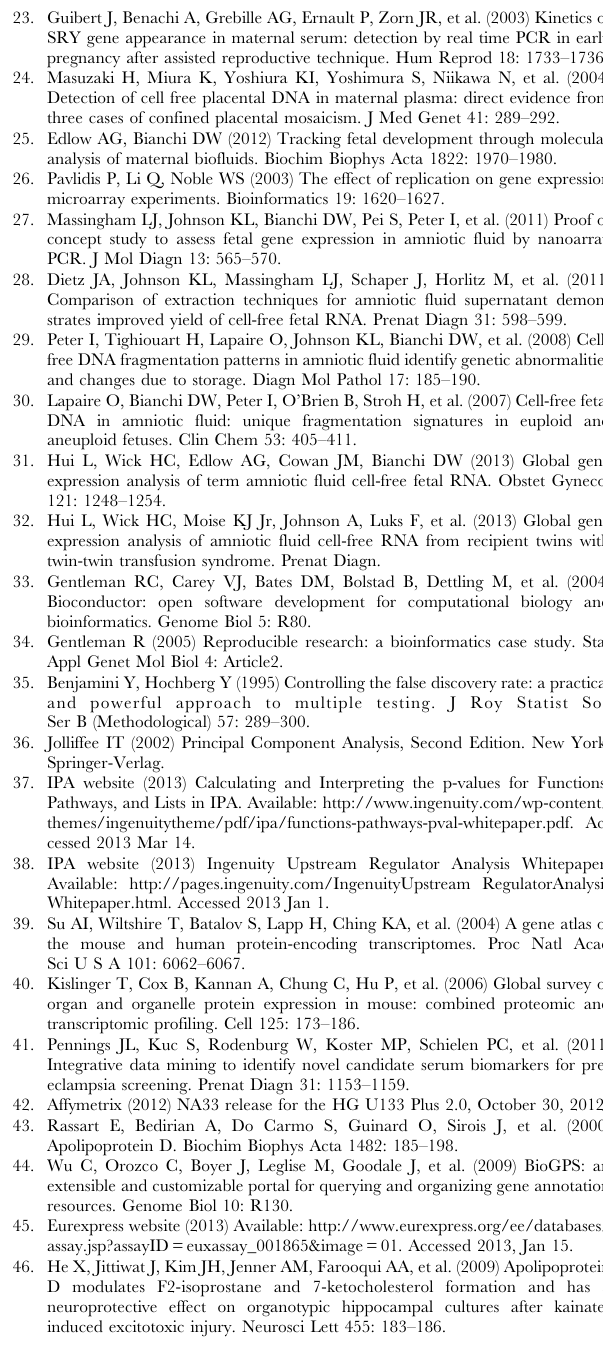
the upper or lower quartile, respectively. The open circles represent values greater than 1.5 times the interquartile range. Table S1 Significantly differentially regulated genes in fetuses of obese versus lean women in the second trimester. Table S2 Significantly differentially regulated molecular and cellular functions in fetuses of obese versus lean women, with associated functional annotations.